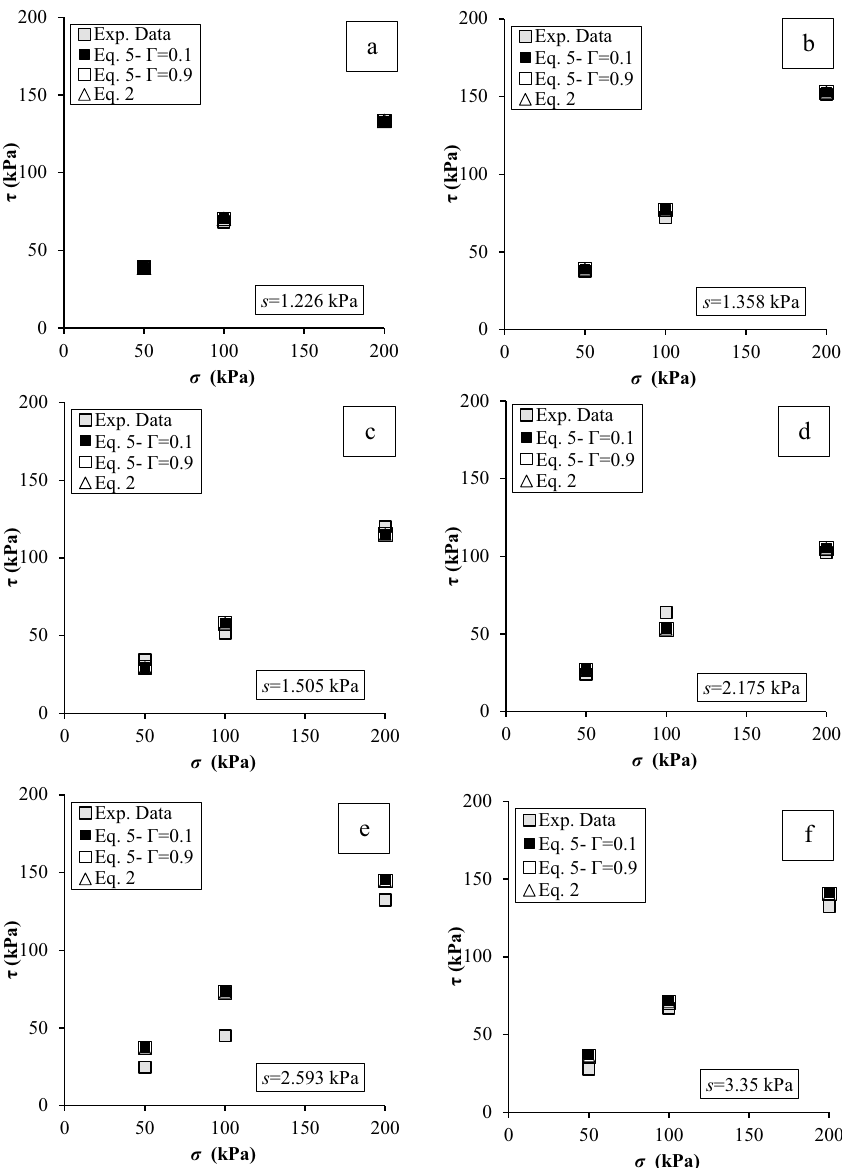
Fig. 4 Evaluation of the effective degree of saturation for sand 1at different suctions ( a ) s s 1.358 kPa, ( c ) s =